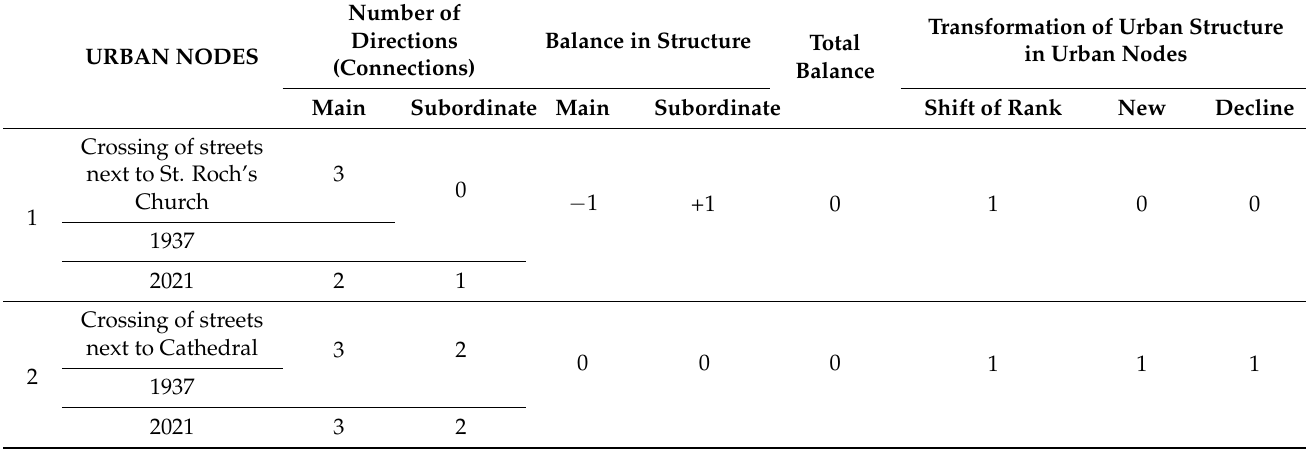
Table 2. Investigation of spatial connections and transformations of selected nodal points; prepared by M. Chodorowski.